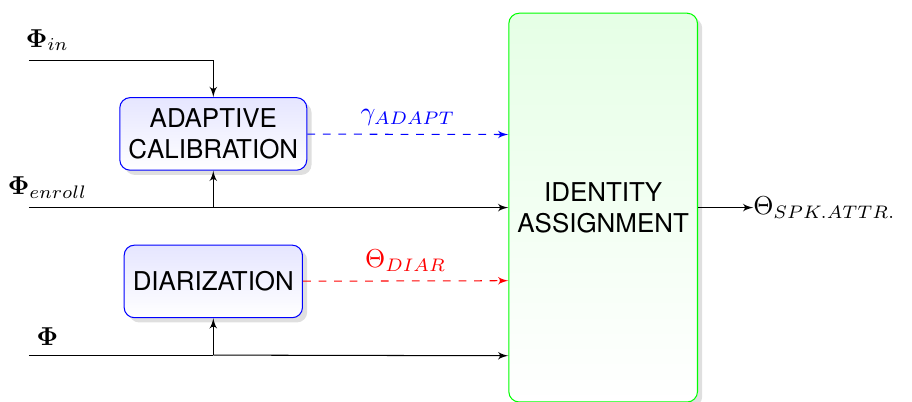
Figure 9. Diagram block for the semisupervised approach based on the indirect assignment